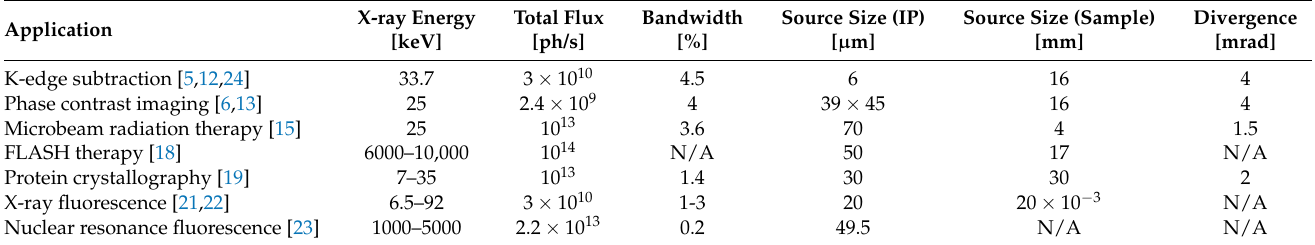
Table 1. X-ray parameters required for ICS applications. In some cases, the information was not available in the literature